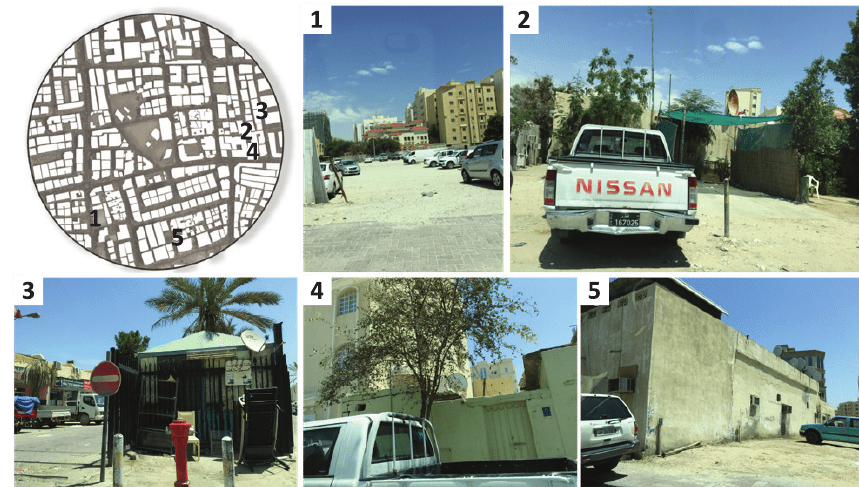
Figure 9. Photographic survey of the area’s open spaces, showing a lack of a sense of place as well as a lack of adequate signage and pedestrian facilities.